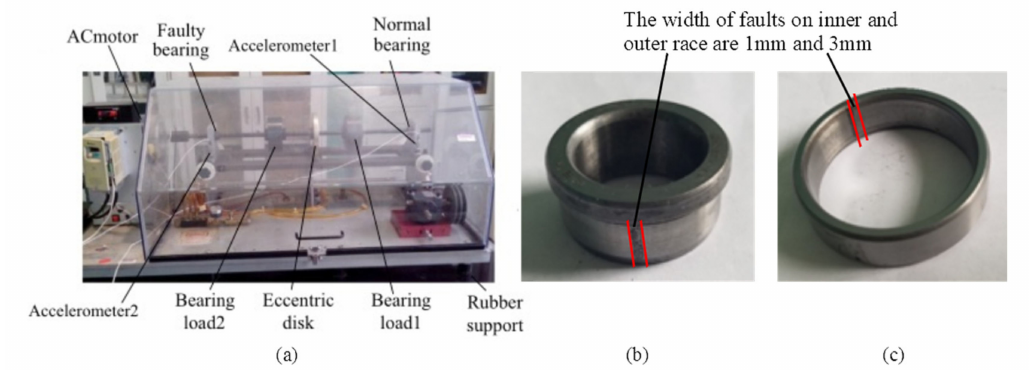
Figure 20. The experiment apparatus: ( a ) The Machine Fault Simulator with an eccentric disk; ( b ) the bearing with the inner race fault; ( c ) the bearing with the outer race fault.